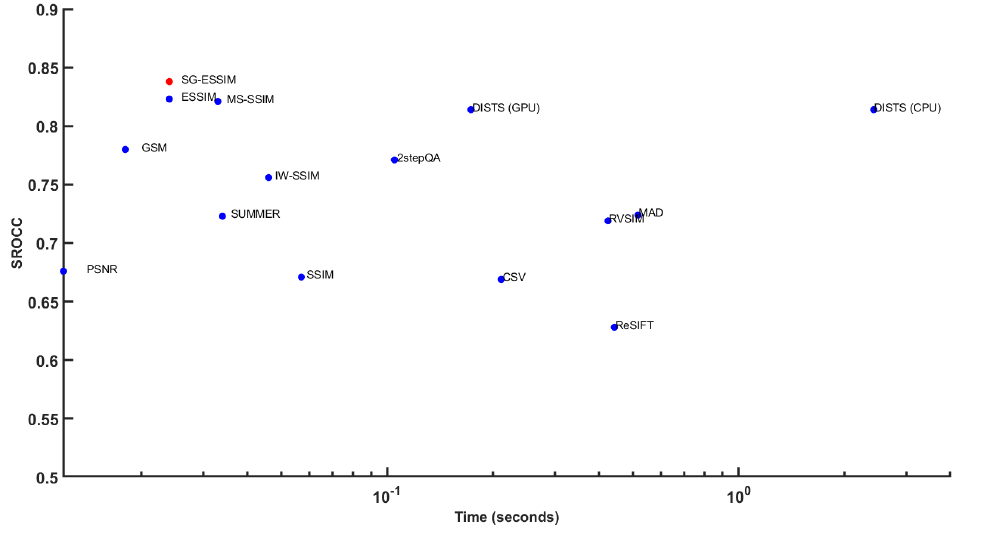
Figure 3. Execution time (logarithmic scale) versus SROCC measured on KADID-10k [20].